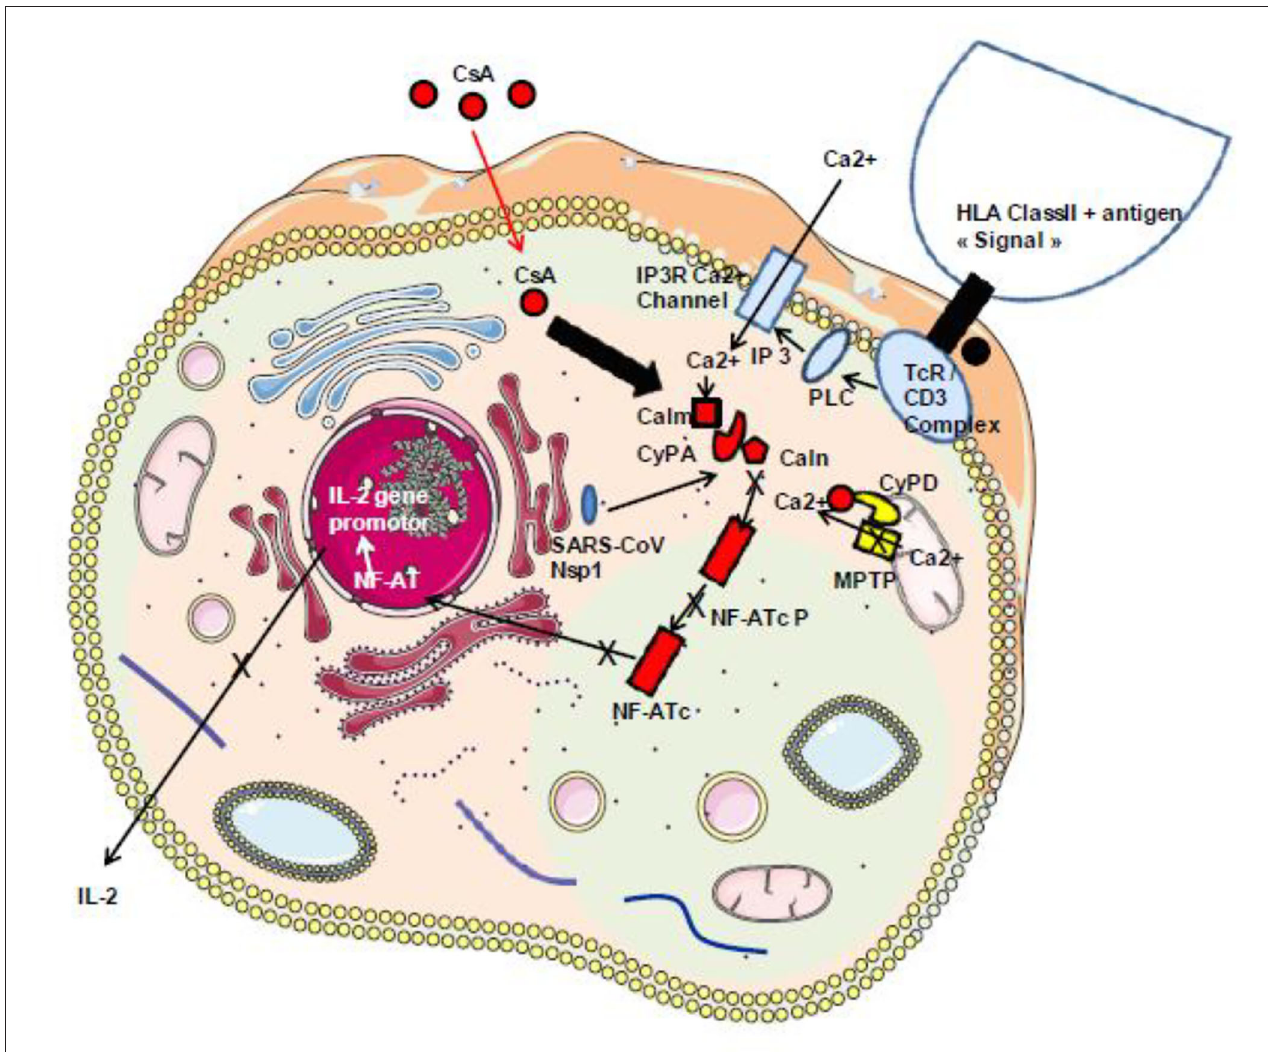
FIGURE 5 | Schematic representation of the classical TcR/CD3-induced activation of IL-2 production. During infection with SARS-CoV-2, the virally induced cell dysregulation leads to the aberrant opening of MPTP inducing mitochondrial release of Ca 2 + that triggers an abnormal Ca 2 + /calmodulin activation of calcineurin and dephosphorylation of the cytoplasmic nuclear factor of activated T cells (NF-AT) leading to NF-AT nuclear translocation and the synthesis of IL-2 and other inflammatory cytokines. Under CsA treatment, the CsA/CyPA complex specifically binds to calcineurin and inhibits its phosphatase function. Consequently, the NF-AT remain under its inactive cytoplasmic phosphorylated form. Moreover, by interacting with CyPD, CsA prevents the opening of MPTP and the release of Ca 2 + that usually lead to cell death. In addition, through binding to CyPA, CsA is expected to upregulate interferon that blocks virus replication. HLA class II, human leukocyte antigen class II; TcR–CD3 complex, T-cell receptor–CD3 complex; PLC, phospholipase C; IP3, inositol 1,4,5-triphosphate; Calm, calmodulin; Caln, calcineurin; NF-ATcP, nuclear factor of activated T-cell cytoplasmic phosphorylated form; NF-ATc, NF-AT cytoplasmic dephosphorylated; PKC, protein kinase C; CsA, cyclosporin